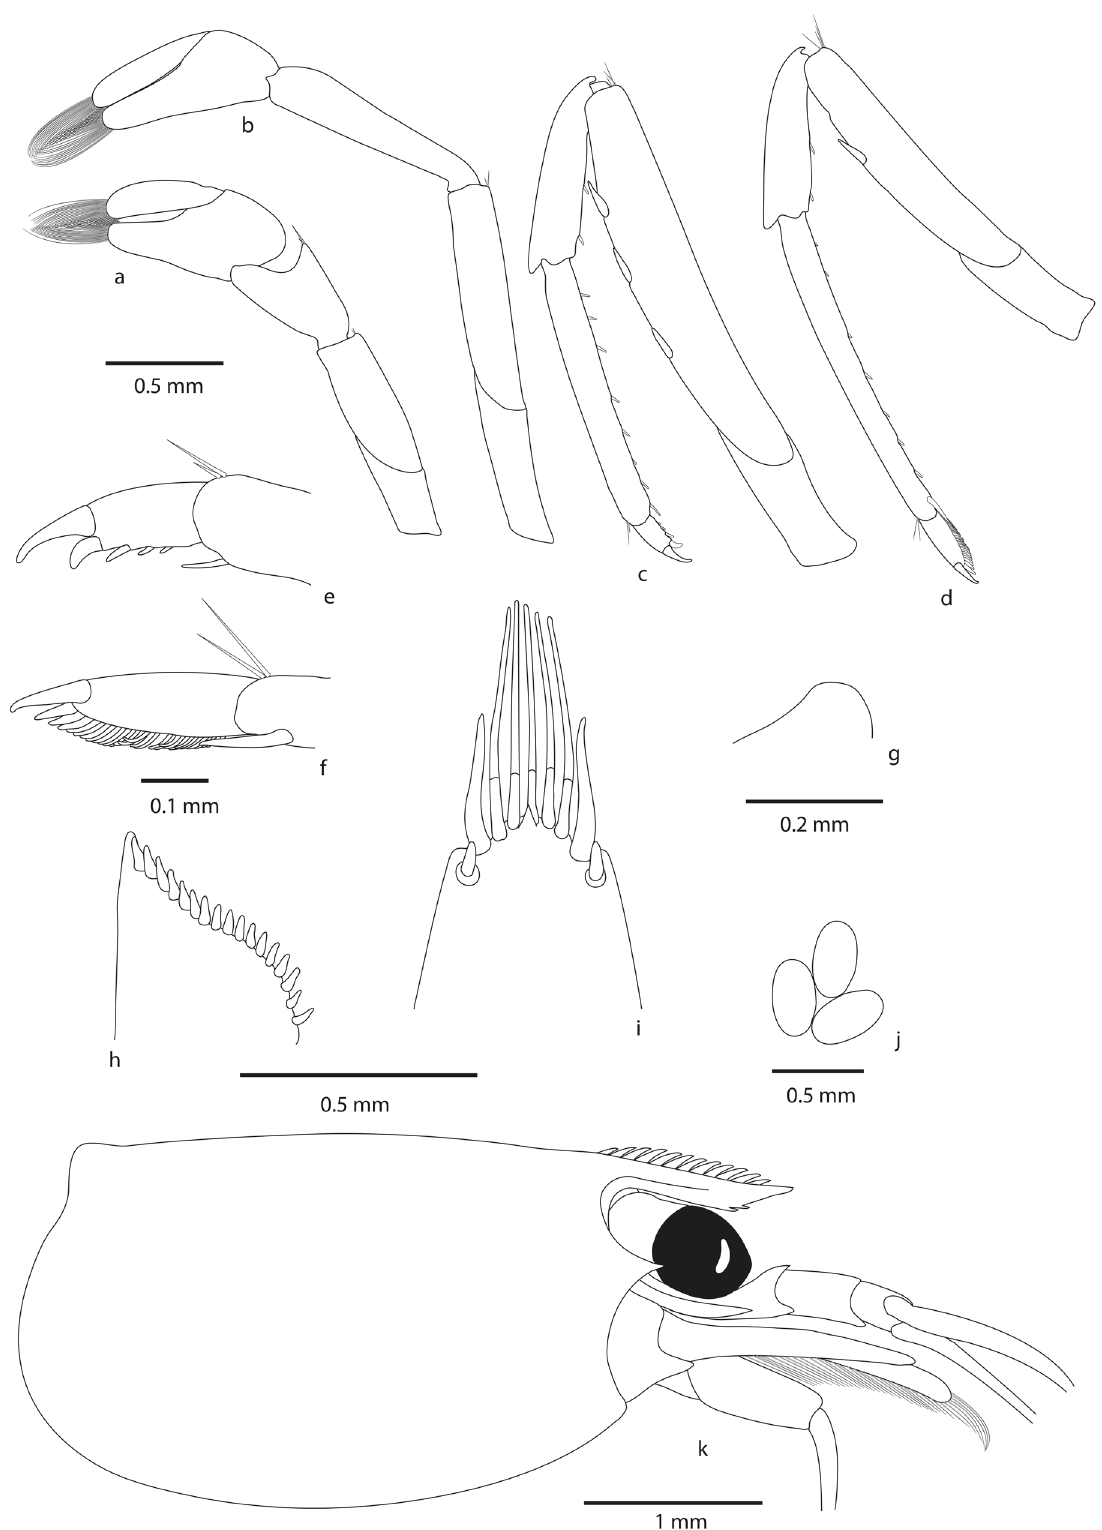
Fig. 18. Caridina piokerai sp. nov. a . First pereiopod. b . Second pereiopod. c . Third pereiopod. d . Fifth pereiopod. e . Dactylus of third pereiopod. f . Dactylus of fifth pereiopod. g . Pre-anal carina. h . Uropodal diaeresis. i . Telson. j . Eggs. k . Cephalothorax. MNHN-IU-2018-2900